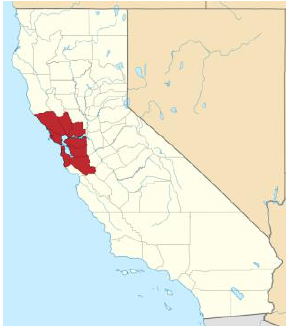
Figure 1. The Bay Area of California (highlighted in red)